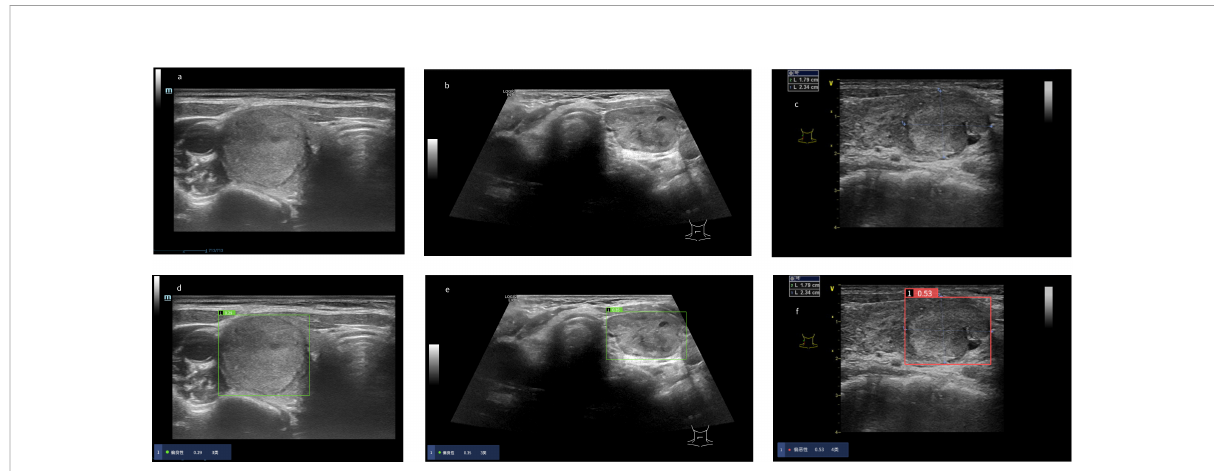
FIGURE 2 Risk coef fi cient assessment and diagnosis of thyroid nodules in the AI system. When the risk coef fi cient of thyroid nodules was < 0.4, the AI system diagnosed the thyroid nodules as “ benign ” as noted in the green display box, otherwise “ malignant ” as noted in the red display box. (A – C) Original ultrasound images of thyroid nodules. (A) Pathological diagnosis: thyroid follicular adenoma. (B) Pathological diagnosis: adenomatoid hyperplasia nodule. (C) Pathological diagnosis: follicular thyroid carcinoma. (D – F) Diagnosis of thyroid nodules in the AI system. (D) The AI system diagnosed the nodule as “ benign ” . Three radiologists diagnosed the nodule as “ malignant ” . (E) The AI system diagnosed the nodule as “ benign ” . Three radiologists diagnosed the nodule as “ malignant ” . (F) The AI system diagnosed the nodule as “ malignant ” . Three radiologists diagnosed the nodule as “ benign ” .